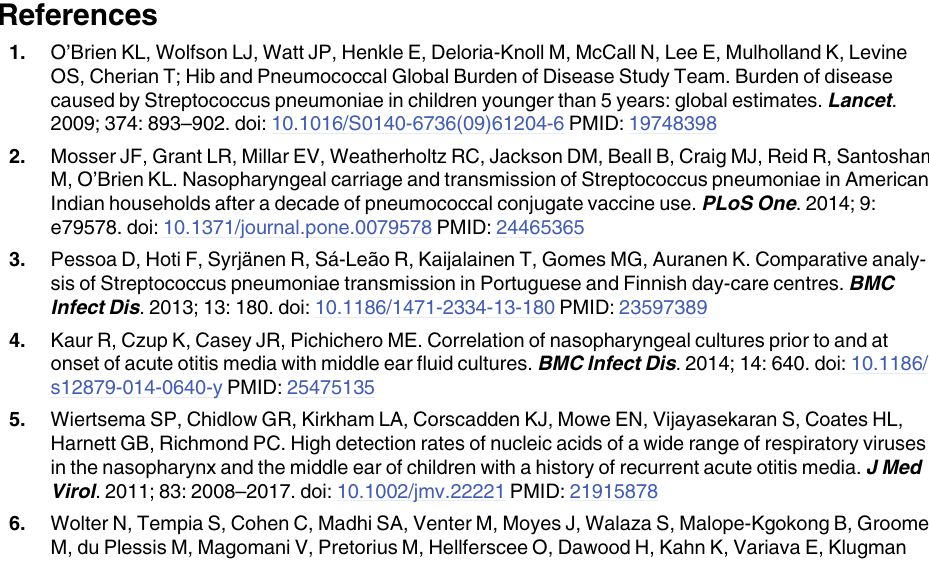
nasally. One of seven representative experiments is shown. All pups were colonized with an equal mixture of the three mutants and their blood cultured when septic or at the time of sacri- fice. Each vertical tick mark on the x-axis represents results of cultures blood from a single pup. Lower panel . A strain obtained (marked by an asterisk) from a contact pup that had been infected with a single mutant was mixed with the other two mutants and rechallenged intrana- sally. A single index pup was colonized and the ability of the three mutants to be transmitted to contact pups compared. One of three representative experiments is shown. Each vertical tick mark on the x-axis represents results of cultures nasal lavages from a single pup. (TIF) S4 Fig. Pneumococcalcolonization among tlr2 -/- mice. Pups were infected with S . pneumo- niae on day 4 and IAV on day 8 of age. Nasal lavages were collected on day 12 of age and the density of colonized pneumococciquantified. A. Wildtype and tlr2 -/- pups infected with P1547. n.s. not significant (Mann-Whitney U test). B. tlr2 -/- index pups (n = 6) infected with an equal mixture of P2396, P2397 and P2405. Repeated measures (RM) one-way ANOVA test was used for statistical analysis. n.s. not significant.